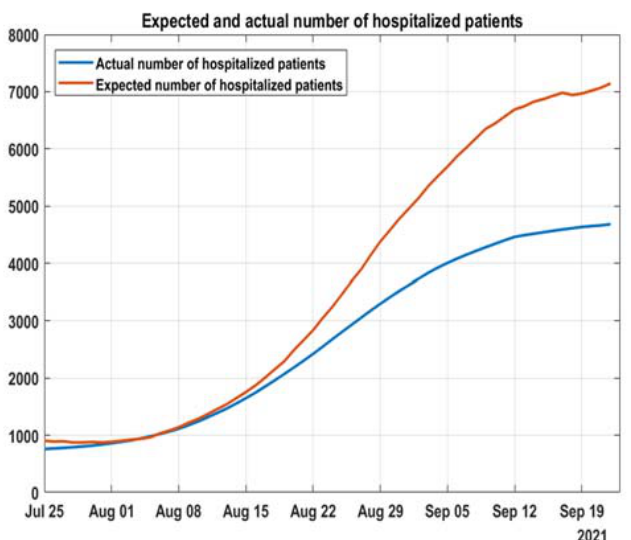
Figure 11. Discrepancy between model and actual hospitalizations.